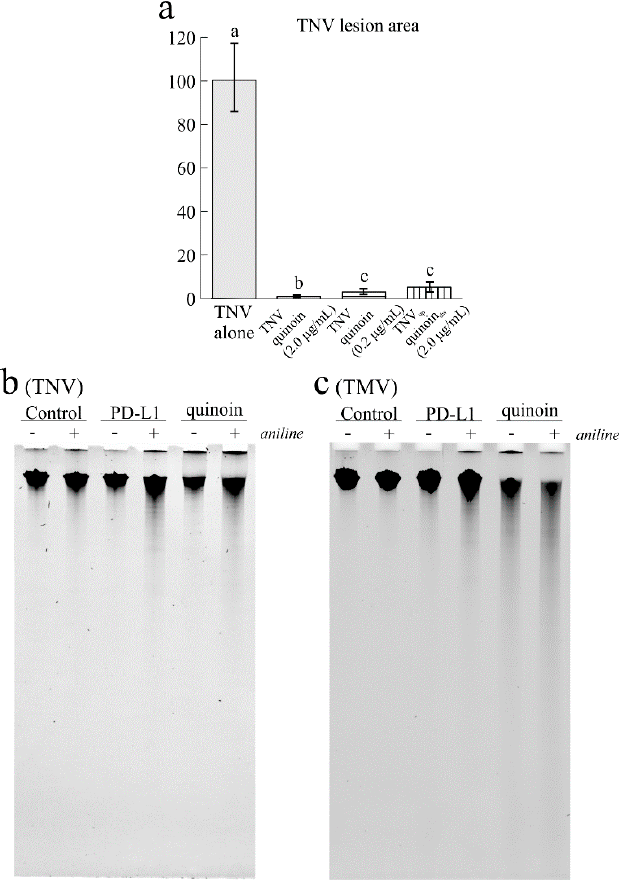
Figure 5. ( a ) The area of TNV lesions developed on bean cotyledonary leaves when the virus was inoculated alone or mixed with different concentrations of quinoin on the adaxial (up) leaf surface, or when inoculated separately from quinoin. The latter was applied on the abaxial leaf surface (down). Data are expressed as percentages of the total lesion area compared to the control (TNV alone) and refer to three independent experiments; different letters represent significant differences according to Fisher’s least significant difference test at p < 0.05; the same letter indicated no significant difference. ( b , c ) The adenine polynucleotide glycosylase activity of 3.0 μ g of quinoin, which was assayed on both TNV and TMV viral RNAs as indicated in the ‘Material and Methods’ section. Each lane contained 3.0 μ g of RNA. Samples were treated (+) or not ( − ) with acid aniline.